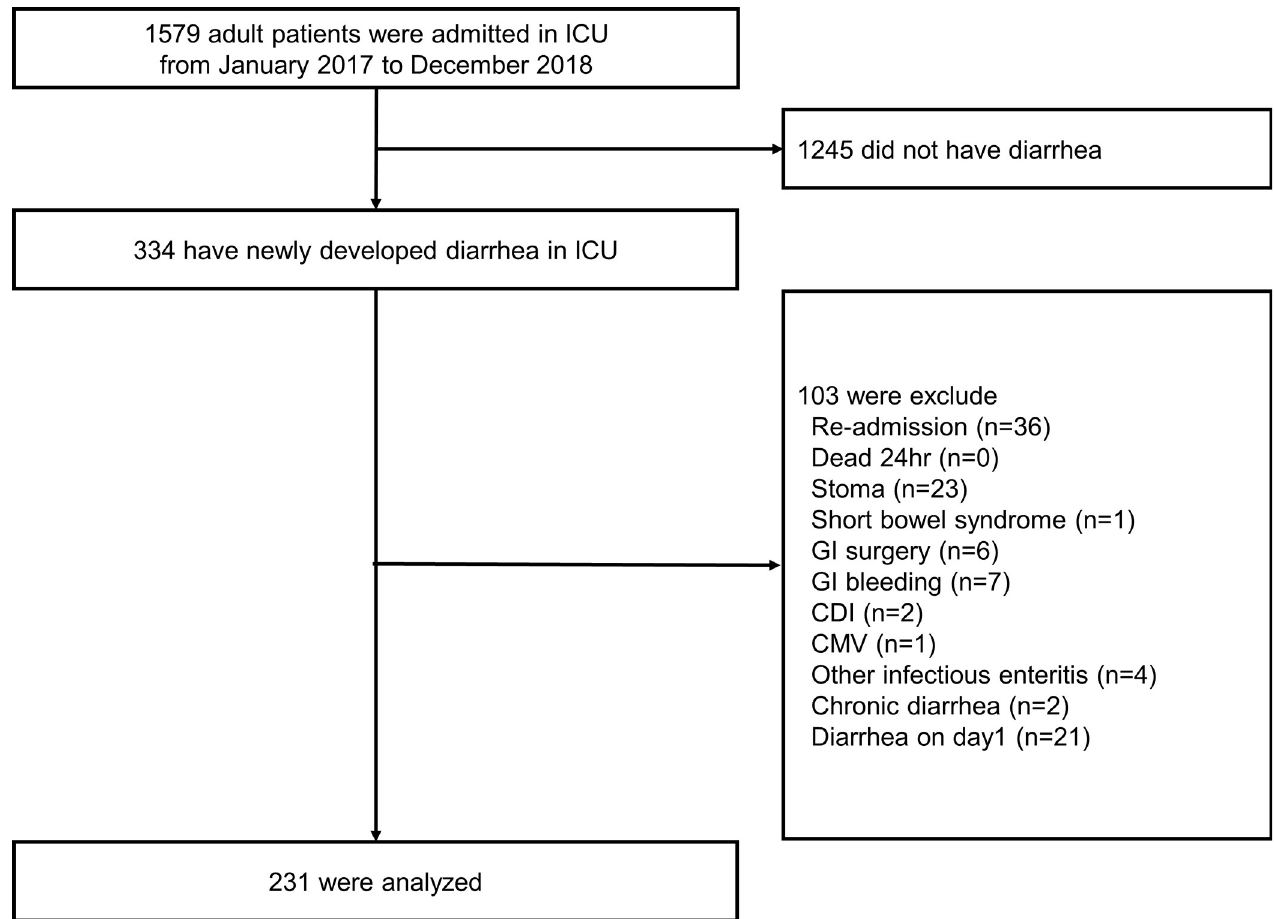
Fig 1. Flow diagram of the sample selection. In our ICU, nurses routinely assess the consistency and quantity of all stools; therefore, no patients were excluded due to missing stool information. GI: Gastrointestinal, CDI: Clostridioides difficile infection, CMV: cytomegalovirus infection.